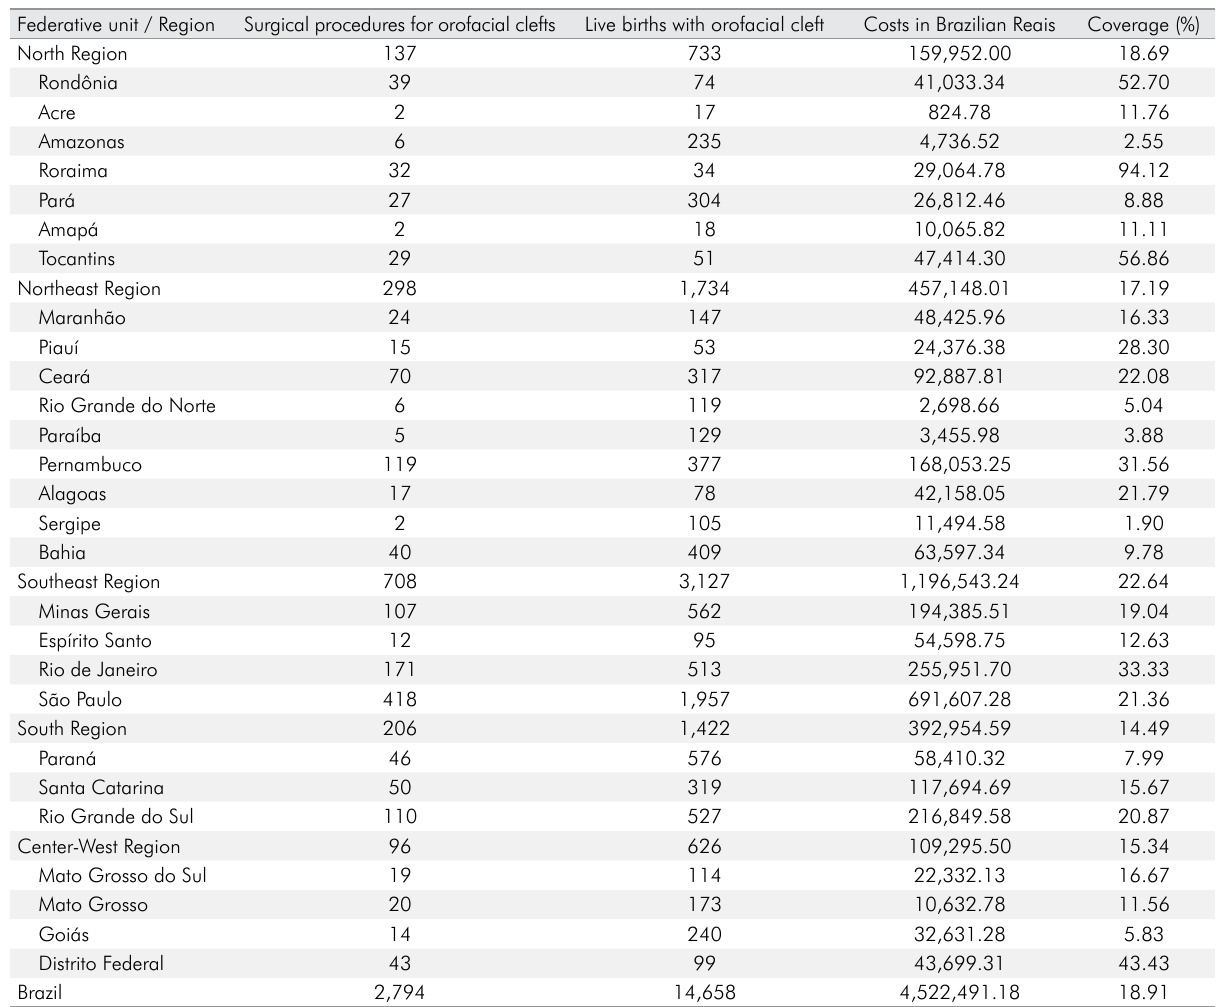
Table 1. Distribution of cases of orofacial cleft, surgical procedures, costs and coverage of surgical procedures in Brazil, 2009-2013. Source: SINASC and